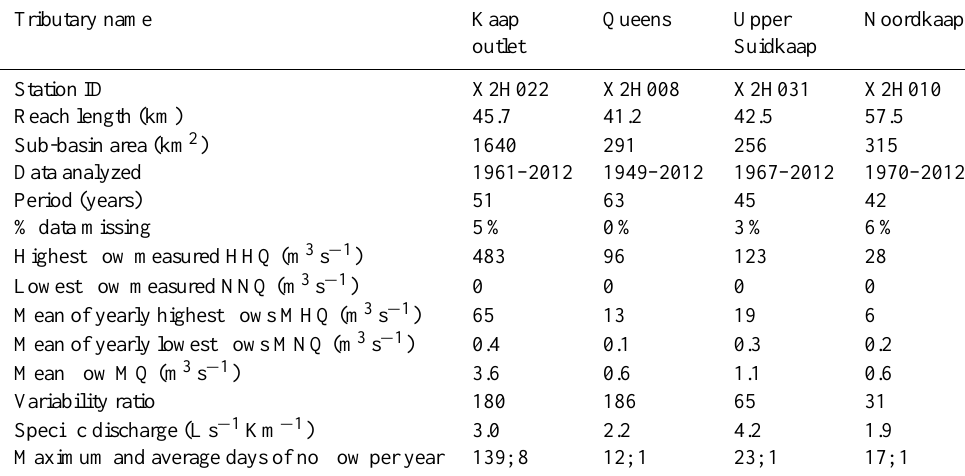
Table 2. Physical and hydrological characteristics of the Kaap tributaries and outlet. Tributary name